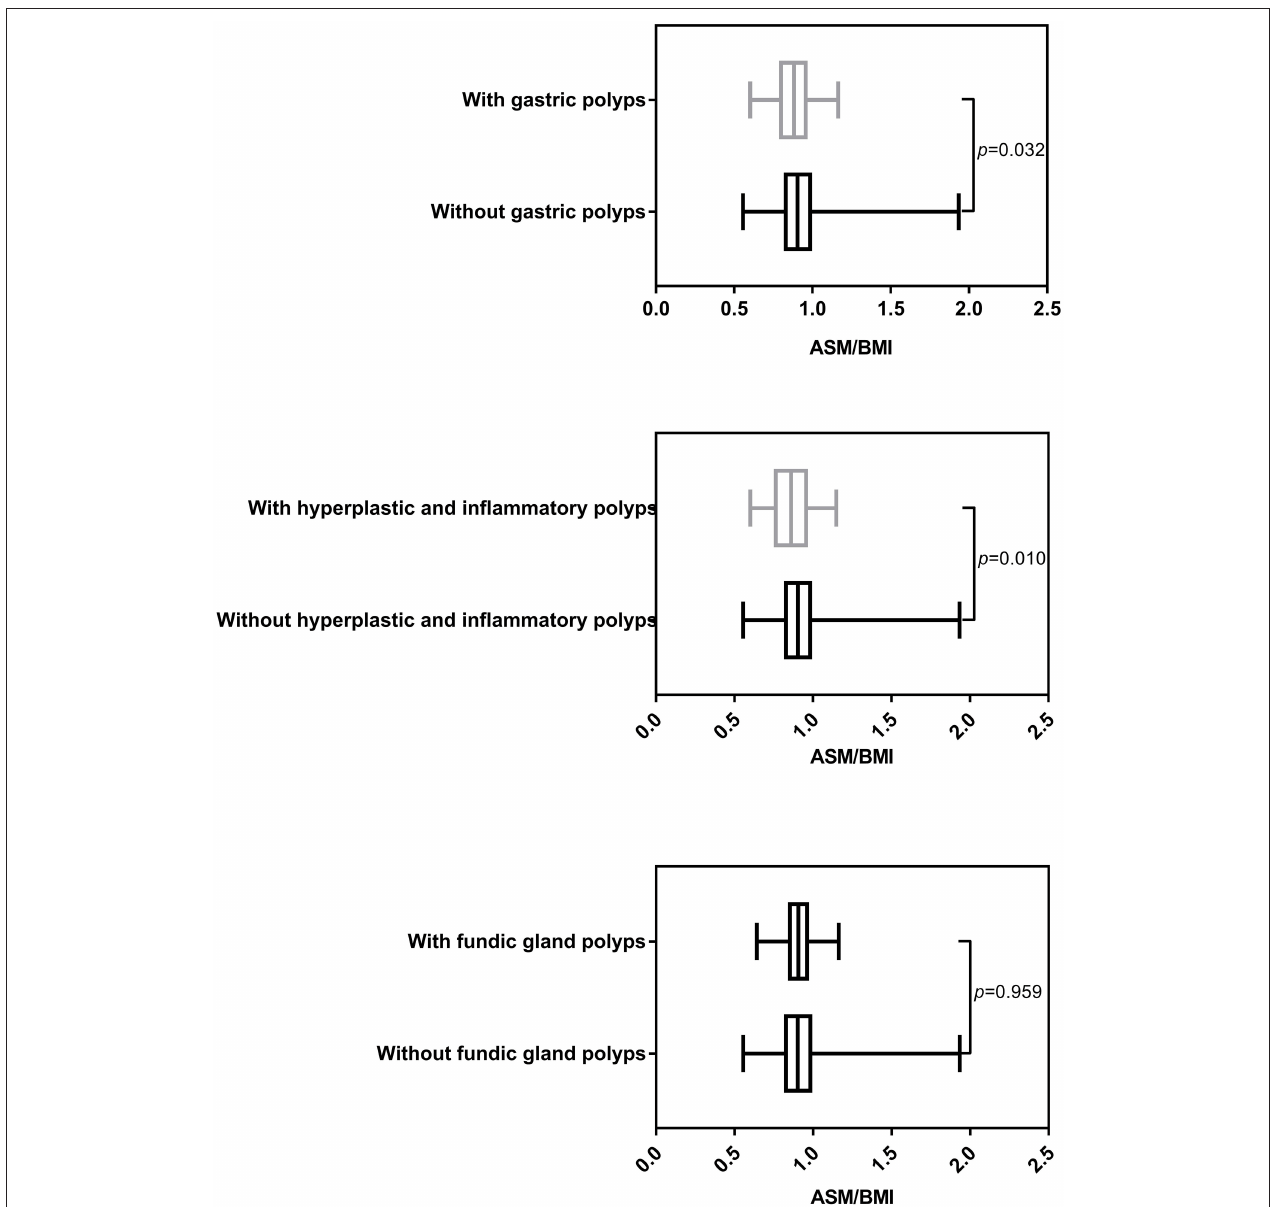
FIGURE 1 | Different ASM/BMI of individuals with and without gastric polyps (including different histological